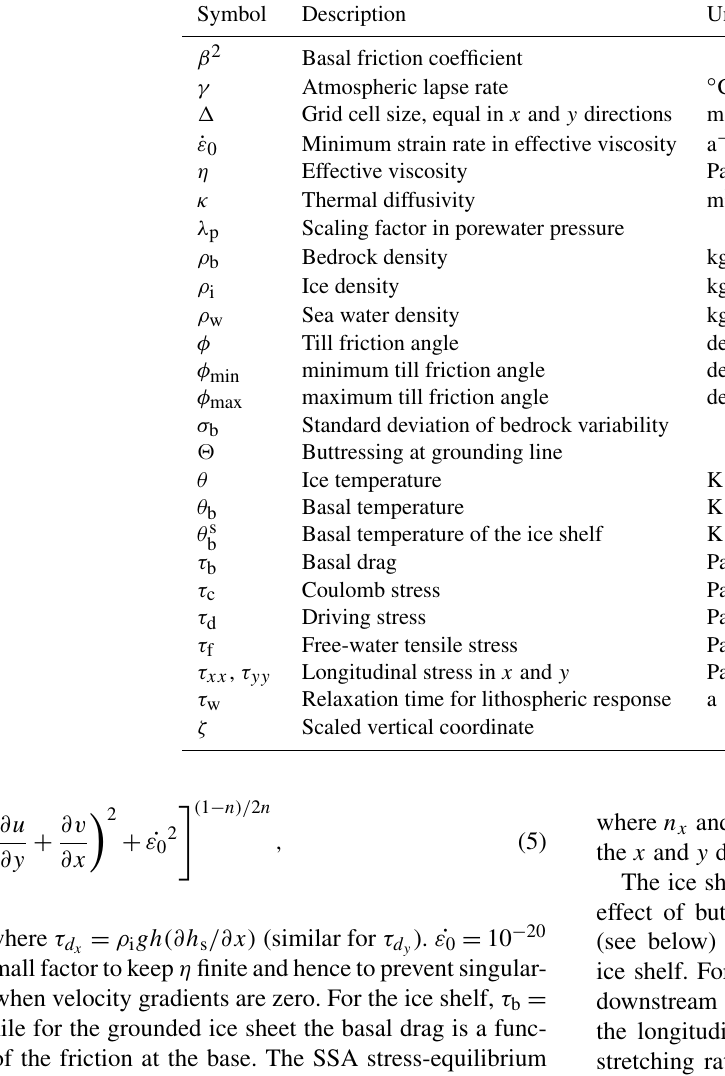
Table 3. Model symbols, units and nominal values (continued)